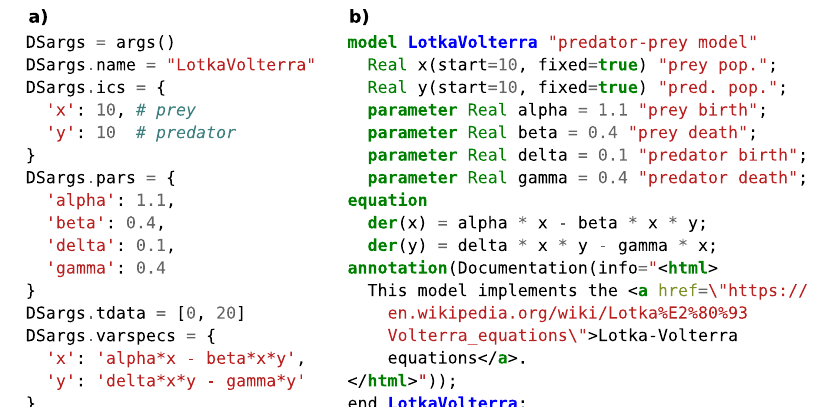
Fig. 2 Simple predator-prey model in a language without (PyDSTool) and with (Modelica) support for documentation strings. a While regular Python comments ( # ) can be used to annotate PyDSTool models, they are ignored by the compiler and are only useful when reading the code directly. b Modelica comments are part of the model syntax and can therefore be read by tools to, e.g., provide automated tooltips in dialogs and graphs or to enrich model summaries in